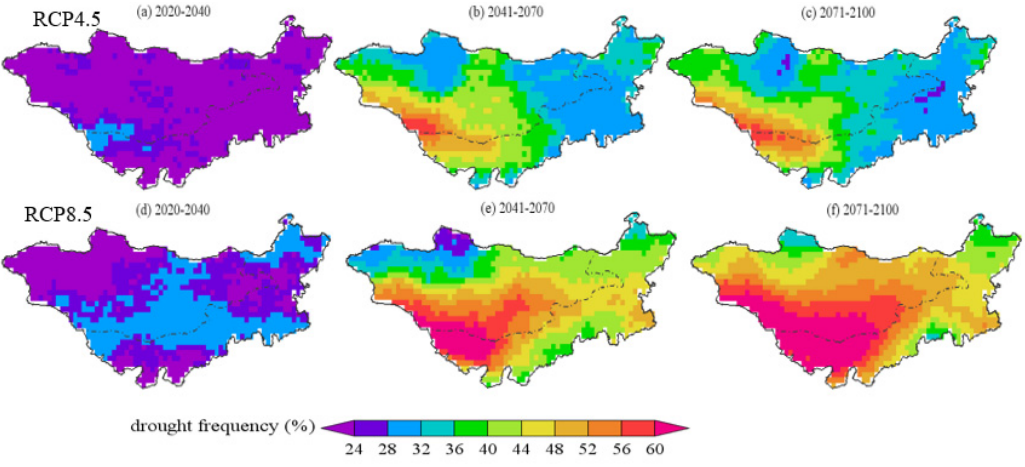
Figure 9. Spatial distribution of drought frequency under different representative concentration